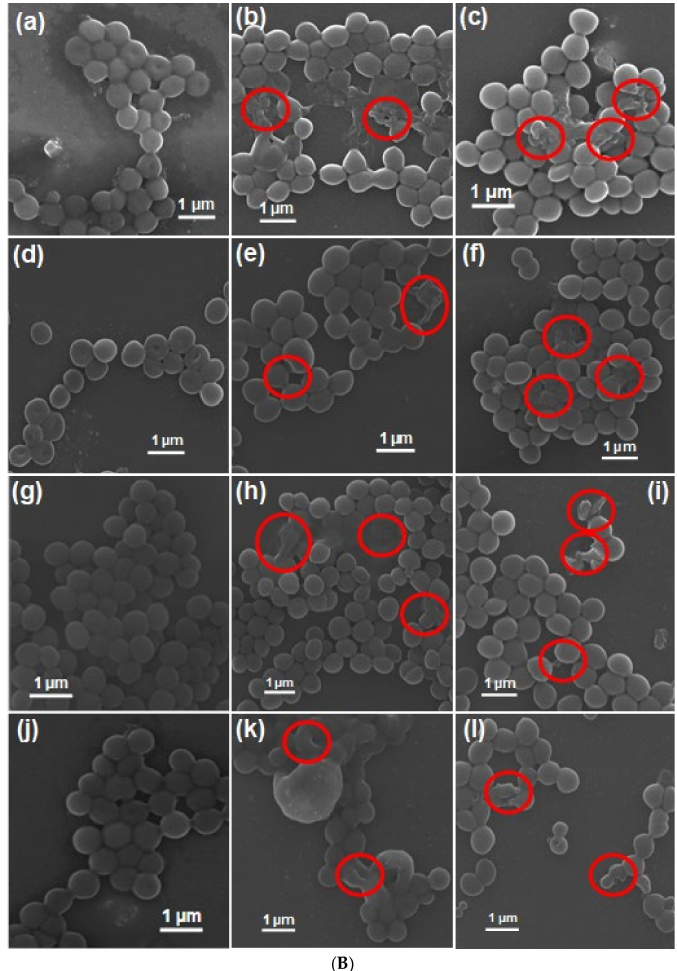
Figure 7. SEM images of bacterial cells after various treatments. ( A ) Untreated (a) S. aureus , (d) MRSA1, (g) MRSA2, (j) MRSA3, and (m) MRSA4. AZB-treated (b) S. aureus , (e) MRSA1, (h) MRSA2, (k) MRSA3, and (n) MRSA4. AZB + NIR-treated (c) S. aureus , (f) MRSA1, (i) MRSA2, (l) MRSA3, and (o) MRSA4. ( B ) Untreated (a) MRSA5, (d) MRSA6, (g) MRSA7, and (j) MRSA8. AZB-treated (b) MRSA5, (e) MRSA6, (h) MRSA7, and (k) MRSA8. AZB + NIR-treated (c) MRSA5, (f) MRSA6, (i) MRSA7, and (l) MRSA8. Disrupted cell membrane regions by treatments are indicated by the red